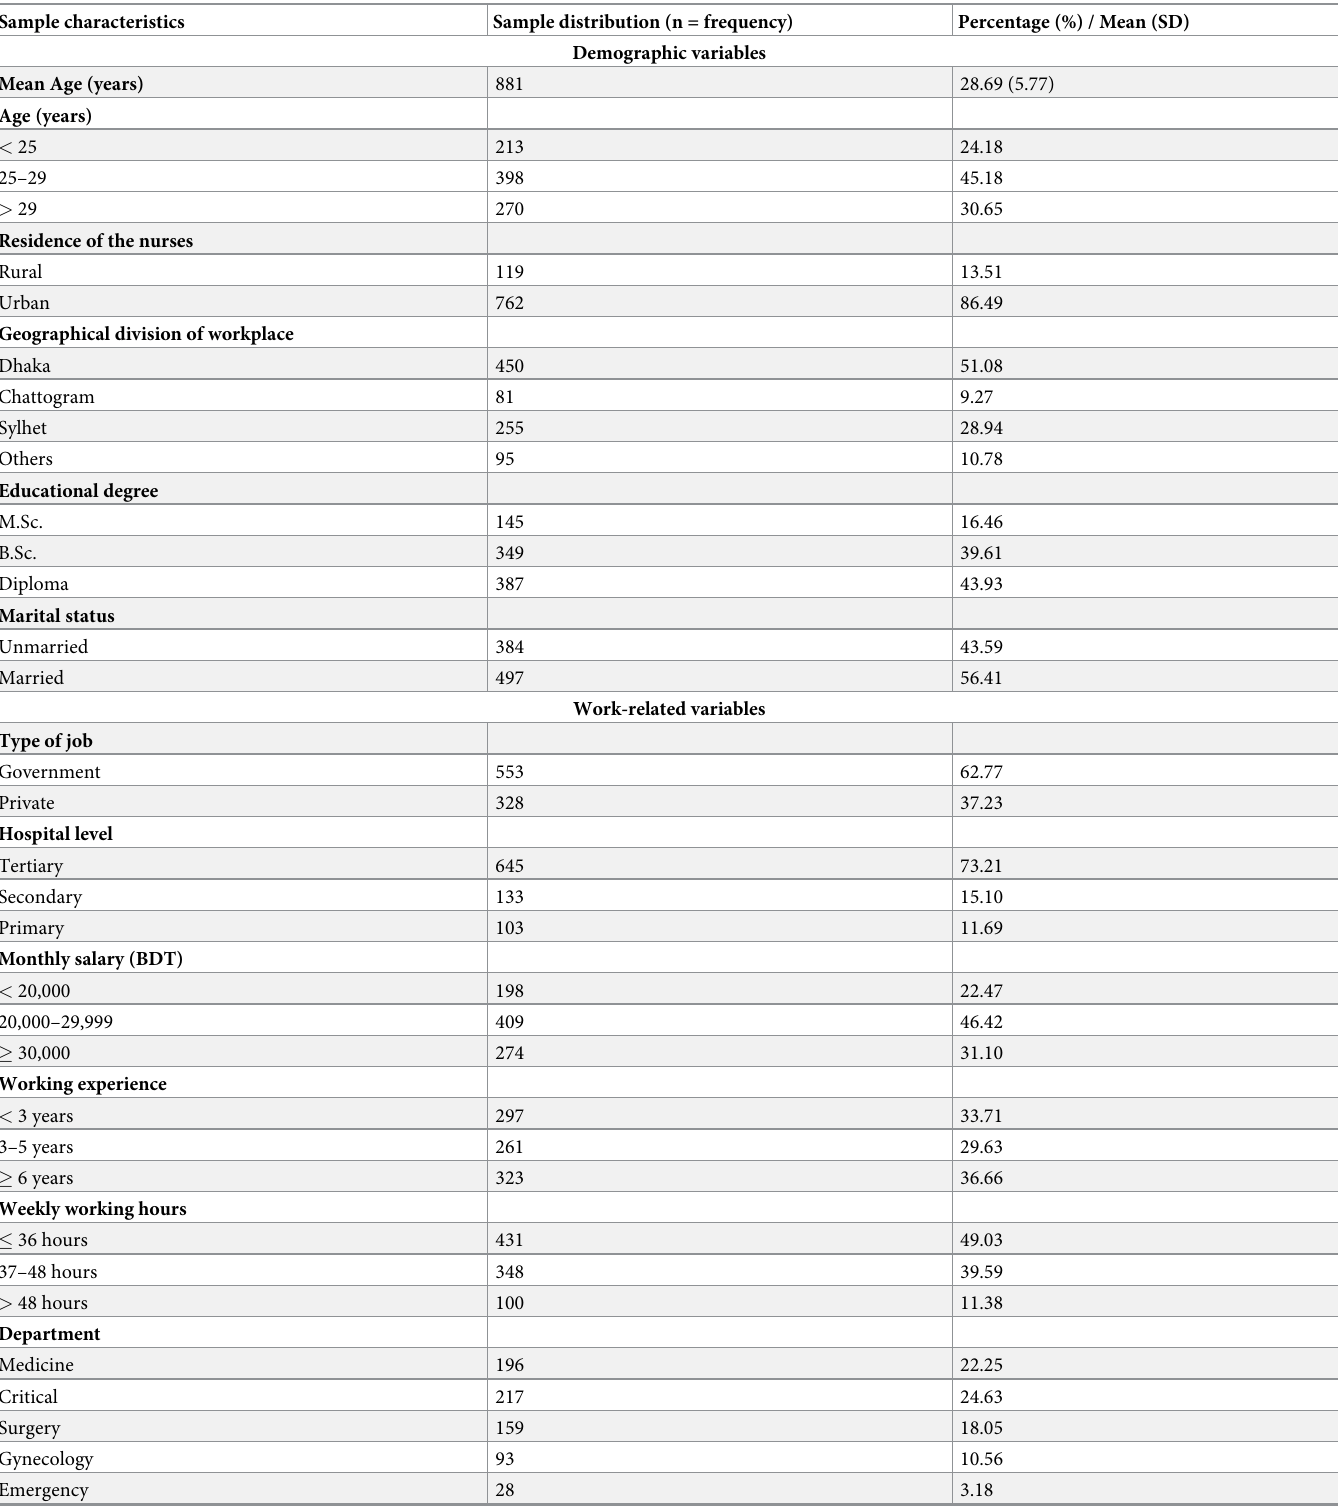
Table 1. Descriptive statistics of the studied variables (n =